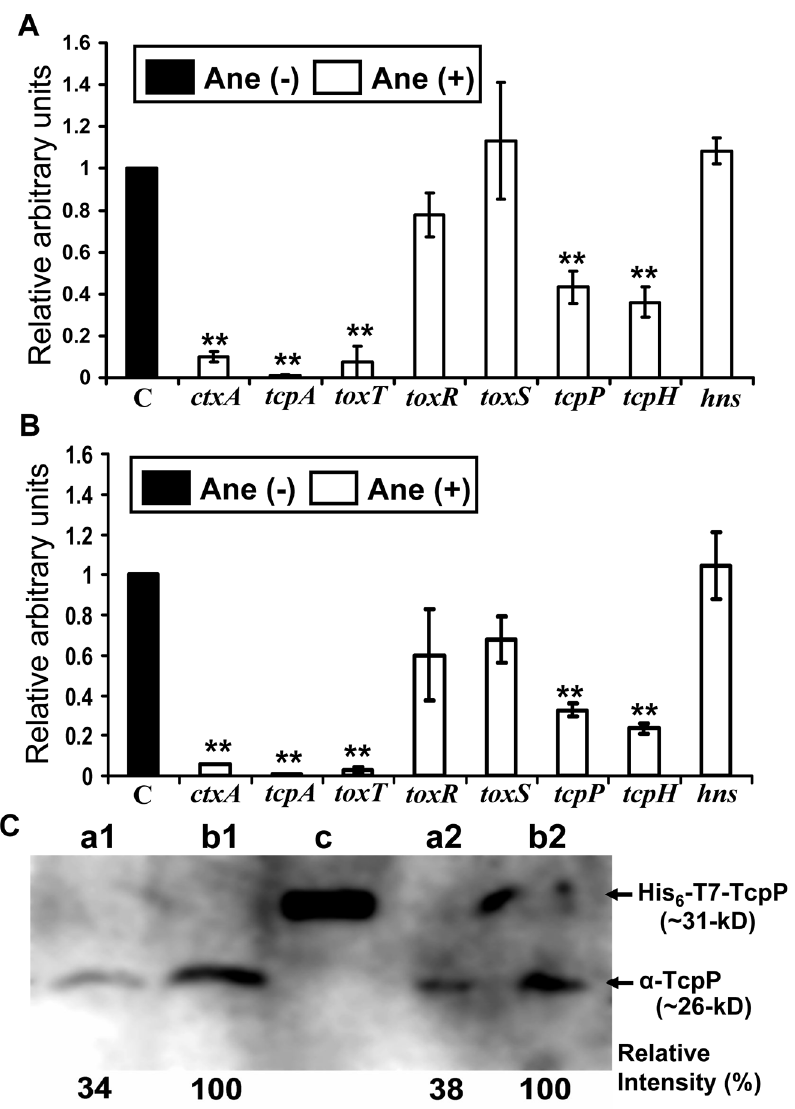
Fig 5. Effect of anethole on the expression of virulence regulatory genes in V . cholerae strain CRC41. qRT-PCR assay of the genes belonging to virulence regulatory cascade was performed with V . cholerae cells cultured (A) at 4 h of stationary and (B) followed by 2 h of shaking conditions, both in the presence (50 μ g/ml) and absence (0.5% methanol) of anethole. ‘ C ’ indicates the control value of each target gene transcription, obtained from without anethole sample (arbitrarily taken as 1). Data are presented as the average ± SD of three independent experiments. By using two-sample t -test, a double asterisk ( ** ) represents p < 0.01 as compared with anethole untreated control. (C) Detection of TcpP by western blotting. Lanes ‘ a ’ and ‘ b ’ indicate TcpP (~26-kD) expression level in the presence (50 μ g/ml) and absence (0.5% methanol) of anethole, respectively. Lane ‘ c ’ indicates the recombinant His 6 -T7-thrombin digestion site tagged TcpP (~31-kD), which was used as a positive control for detection of TcpP (See Methods section). In left panel (lanes a1 & b1), proteins were obtained from initial 4 h of stationary culture and right panel (lanes a2 & b2), proteins were from initial stationary followed by 2 h of shaking culture. This image is a representative of the three independent observations. The relative band signal intensities (shown below the image) of the image of western blot was quantified by ImageJ software, and normalized to that of without anethole sample (arbitrarily taken as